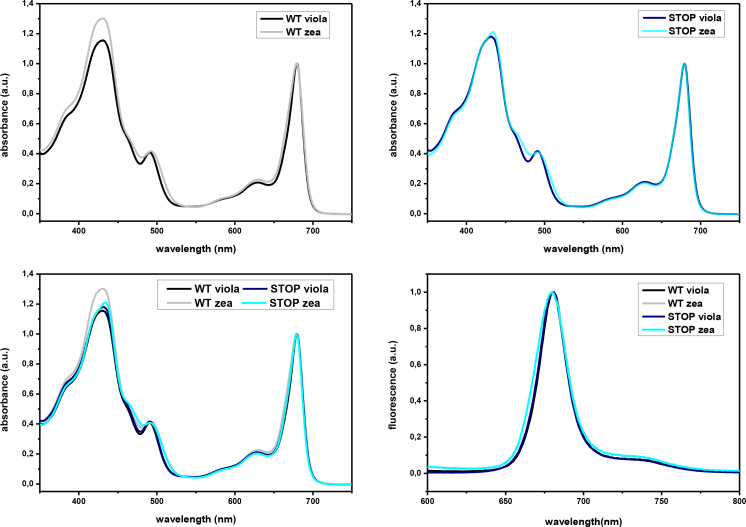
Absorption and fluorescence emission spectra of LHCSR3 WT and STOP.(a–c) Absorption spectra of WT (a) or STOP (b) refolded with violaxanthin or zeaxanthin. (d) Fluorescence emission spectra of LHCSR3 WT and STOP mutant upon excitation at 440 nm with both violaxanthin and zeaxanthin pigments composition. The results reported are representative of two independent experiments.